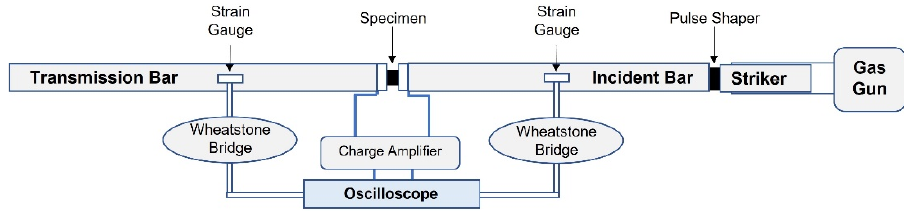
Figure 2. A schematic of the Kolsky bar set-up.